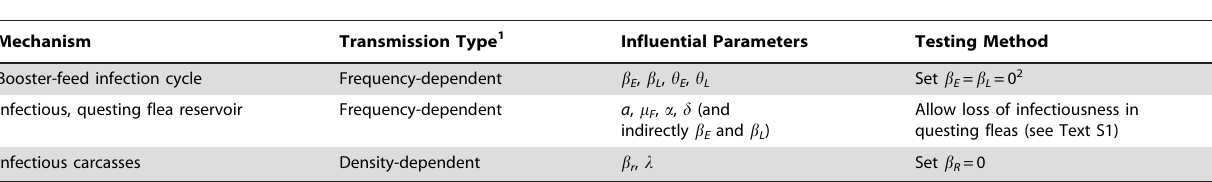
Table 3. Transmission